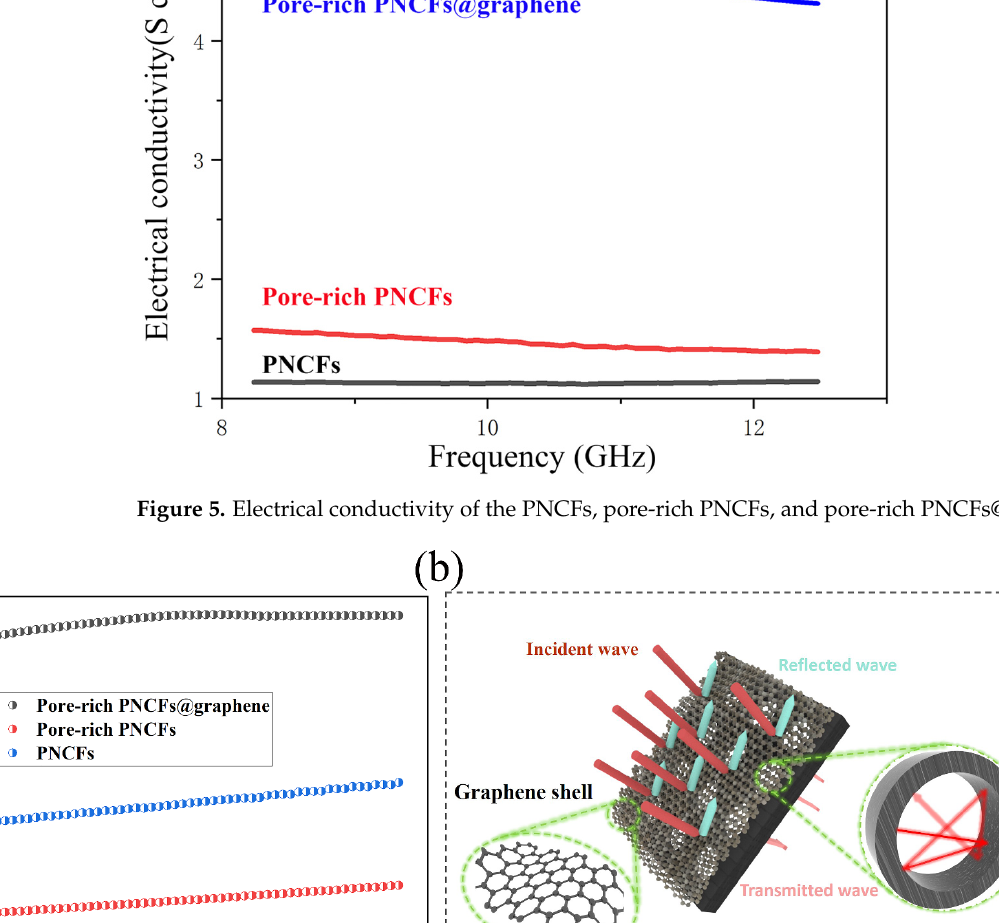
Table 2. Recently reported SE T value of some biomass-based EMI shielding materials.